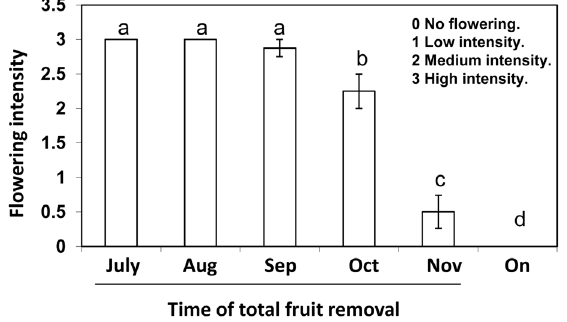
Figure 2. Effect of fruit load on return to flowering. Complete fruit removal treatments, starting in July, 2011, were performed as described in the legend to Fig. 1. Flowering-intensity levels of treated (de-fruited) and untreated ( on ) trees were ranked at the onset of the following spring (March, 2012). Values represent means 6 SE of four trees per treatment and different letters indicate significant differences.